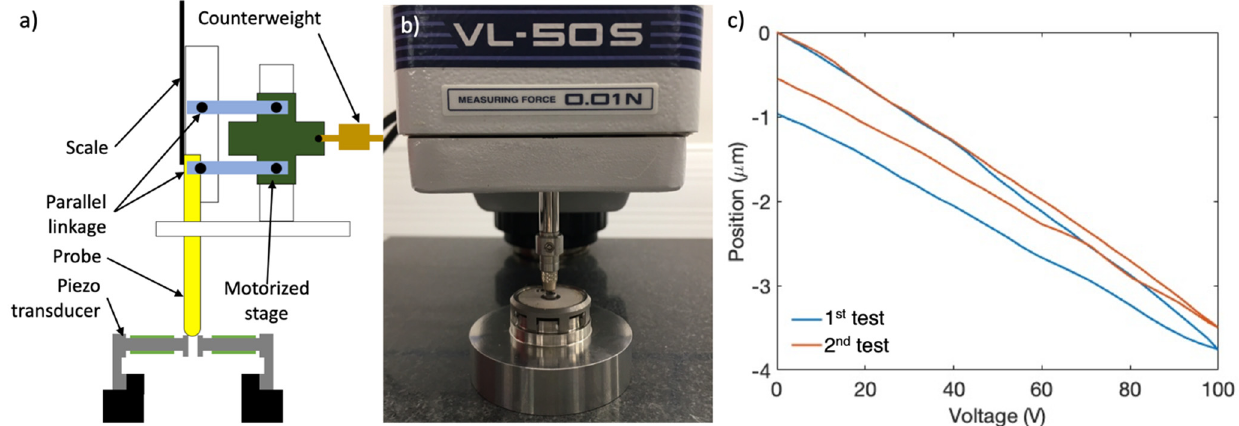
Figure 4. Schematics and results of the contact-based measuring technique. ( a ) Schematics of the parallel linkage system used in Litematic VL-50S-B; ( b ) image of the piezo transducer test bench; and ( c ) piezo control voltage–probe position figure.